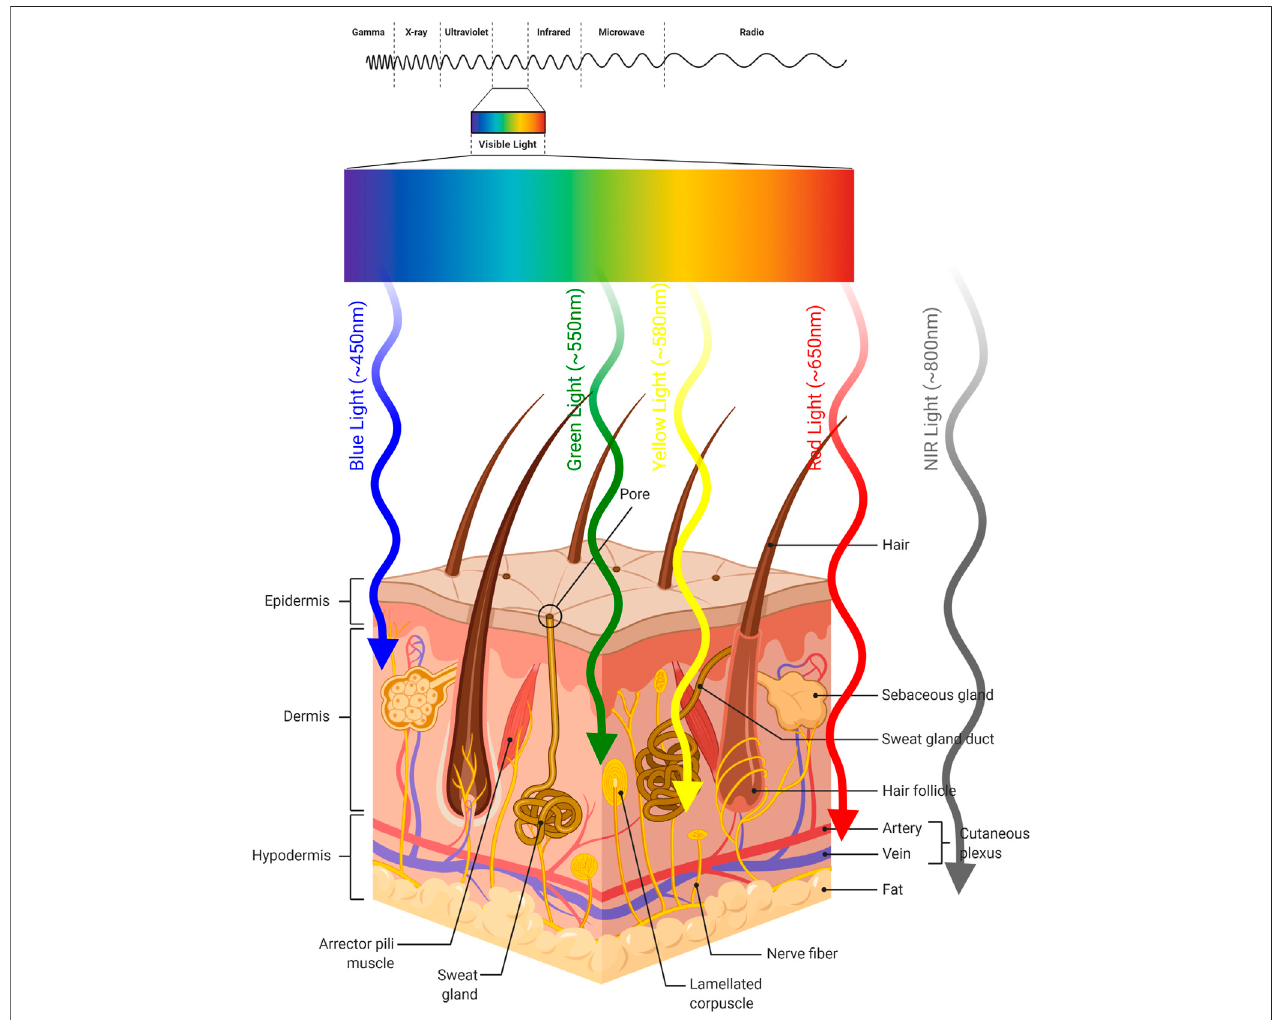
FIGURE 5 | Light Penetration into Skin. Approximate penetration depths of light into skin according to its wavelength are illustrated.